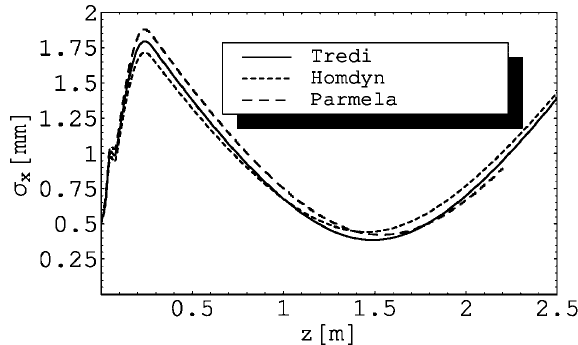
FIG. 8. Radial envelope (mm).